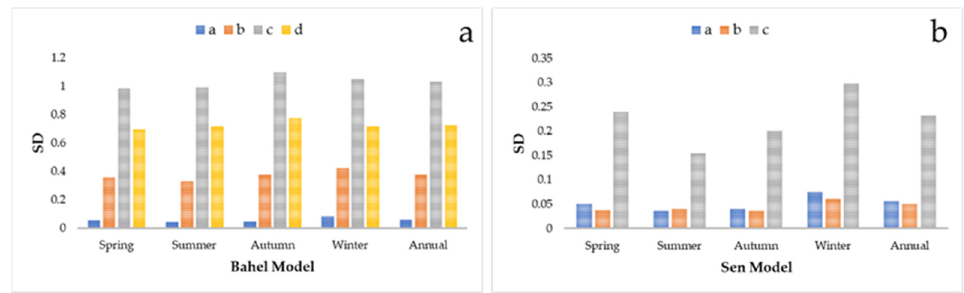
Figure 6. Degree of dispersion of empirical coefficients for the Bahel Model ( a ) and Sen Model ( b ).